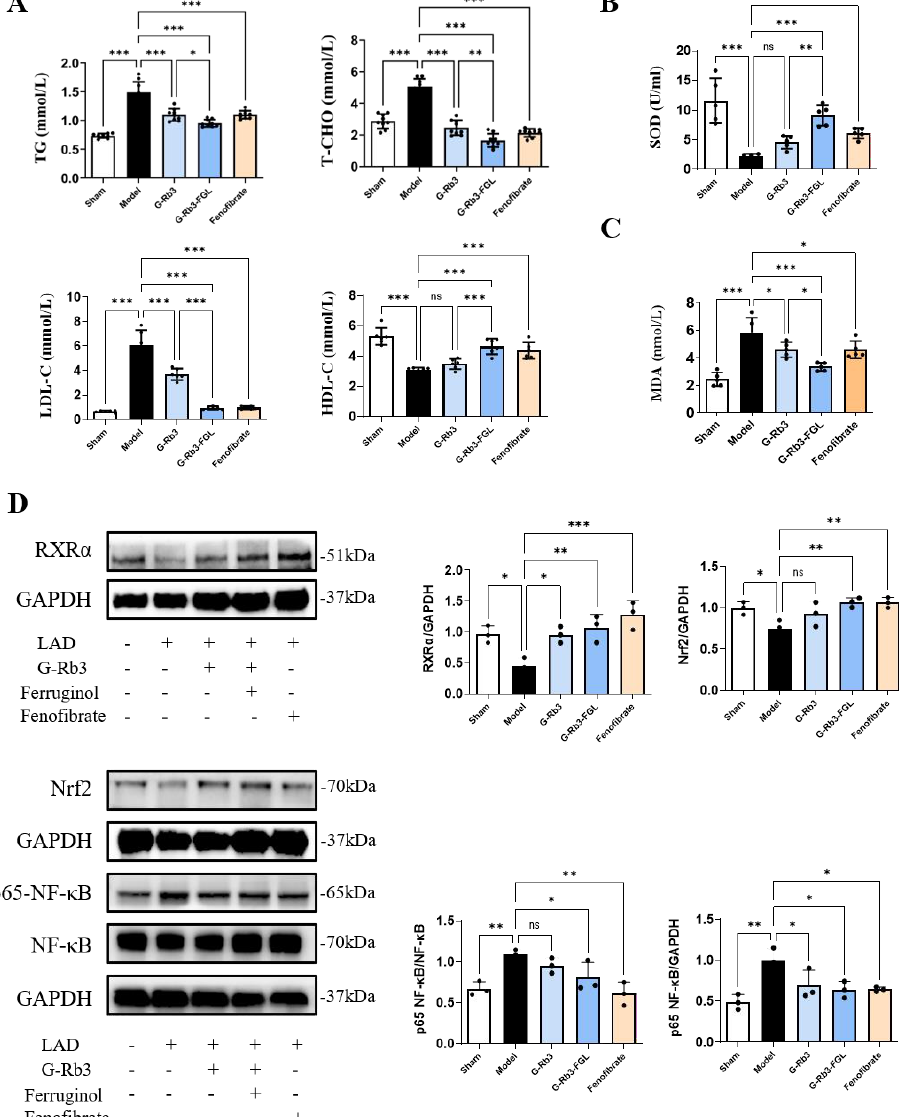
Figure 2. G-Rb3-FGL co-treatment alleviated dyslipidemia and oxidative stress in MI mice. ( A ) Levels of TG, T-CHO ( N = 9 per group) and HDL-C, LDL-C ( N = 6 per group) in serum. ( B , C ) Levels of SOD and MDA in serum. N = 5 per group. ( D ) The relative protein levels of RXR α , Nrf2 and p65-NF- κ B in heart. All data were presented as means ± SD from independent experiments performed in triplicate. ns No statistical significance, * p < 0.05, ** p < 0.01, *** p < 0.001 vs. model group. N = 3 per group.